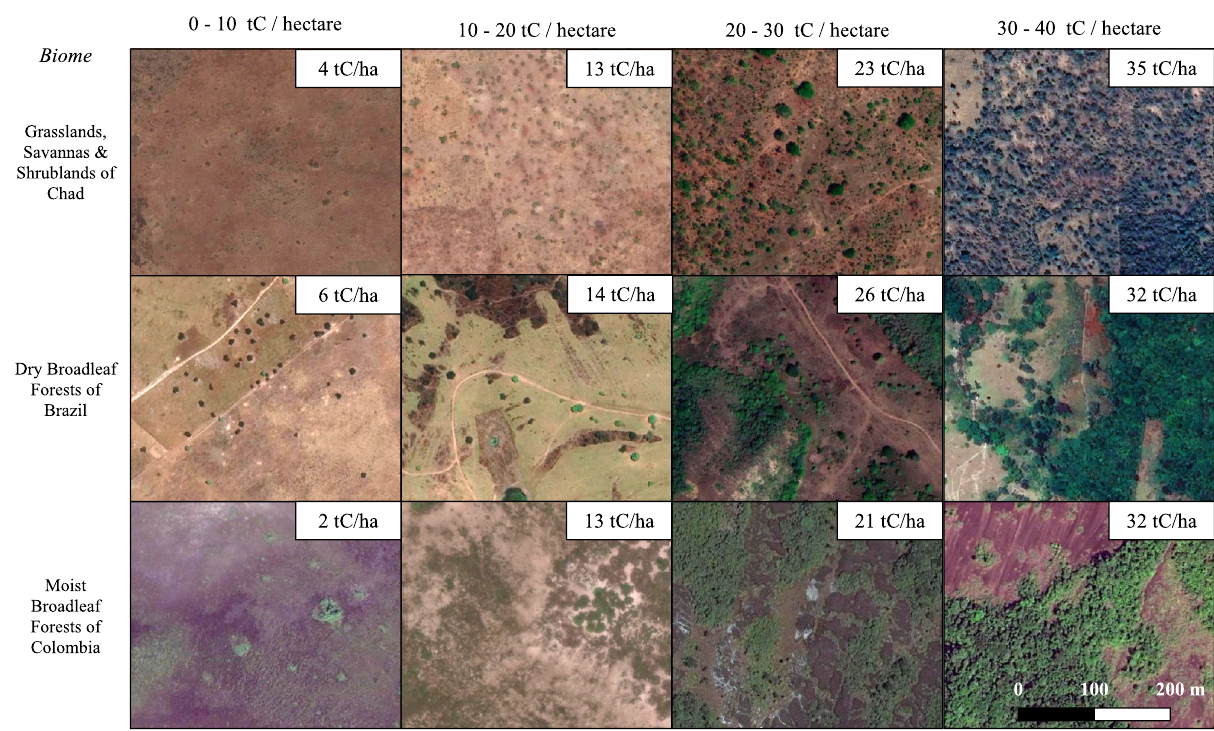
Fig. 1 Silvopasture density. A visual guide to silvopasture systems in different biomes and with a range of woody carbon densities. Each row presents a biome type where silvopasture occurs in our study regions in the Americas and Africa, and the columns present a range of carbon density within each